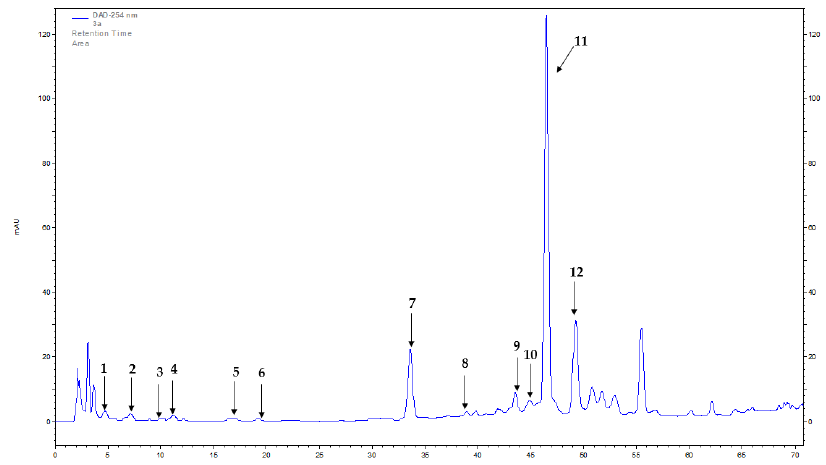
Figure 1. HPLC-DAD ( λ = 254 nm, UV spectra range 200–400 nm) chromatogram of hot-air-dried herb methanol extract of B. officinalis ; (1) protocatechuic acid, (2) 3,4-dihydroxyphenylacetic acid, (3) p -hydroxybenzoic acid, (4) chlorogenic acid, (5) caffeic acid, (6) syringic acid, (7) ferulic acid, (8) vitexin, (9) kaempferol 4-glucoside, (10) rutoside, (11) rosmarinic acid, (12) astragalin.